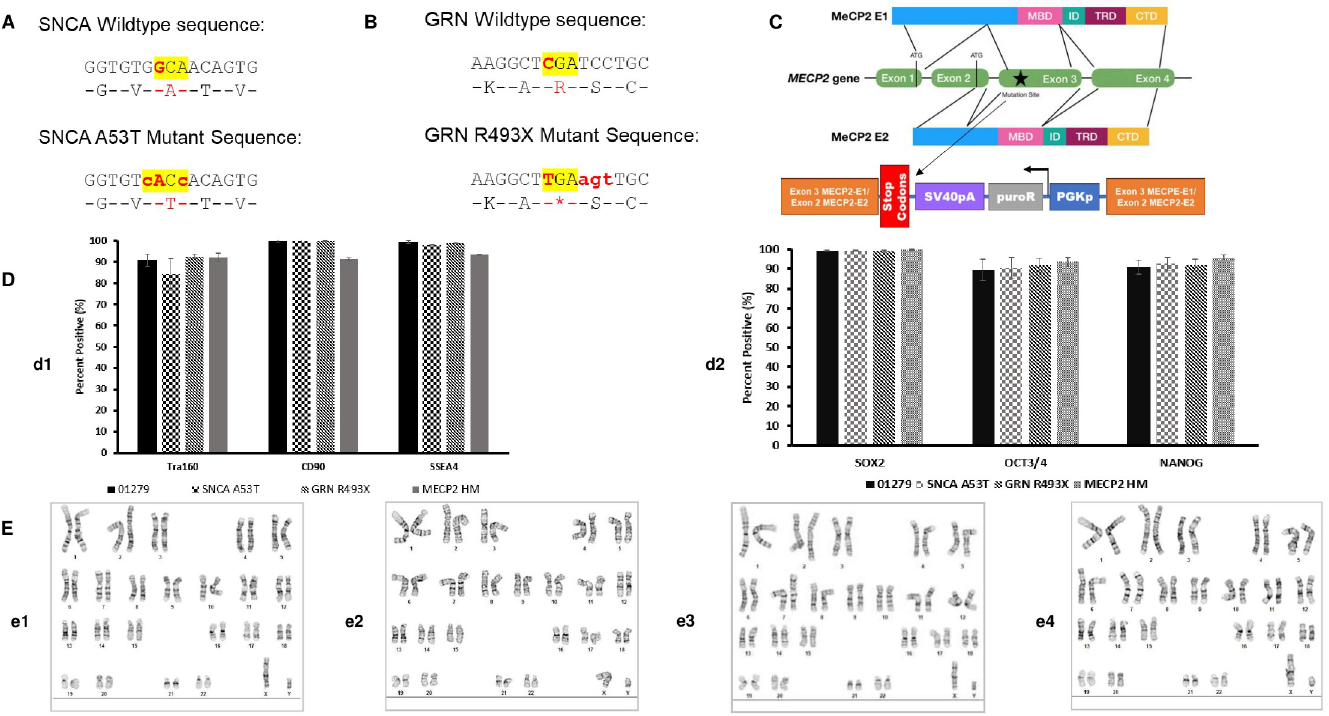
Fig 1. Generation and characterization of isogenic iPSCs for disease modelling. (A) SNCA A53T engineering is schematically described, showing the amino acid 53 change from alanine to threonine highlighted in yellow. (B) GRN R493X engineering is schematically described, showing the amino acid change of arginine 493 to a termination codon highlighted in yellow. (C) MECP2 HM KO engineering is schematically described, showing insertion of stop codons prior to Methyl CpG Binding domain followed by a PGKp-PuromycinR-SV40pA selection cassette. (D) iPSC characterization preformed using flow cytometry for the presence of traditional pluripotency markers. (d1) Detections of surface markers Tra160, CD90, SSEA4, and (d2) intracellular markers SOX2, Oct3/4, and Nanog. Each graph quantifies percentage of pluripotency markers (n = 4 ± SE) for 01279, SNCA A53T, GRN R493X, and MECP2 HM. Parental and engineered cell lines all displayed surface and intracellular markers confirming a pluripotent state. (E) Cytogenetic analysis on G-banded metaphase cells from each iPS cell line detailing a normal karyotype, (e1) 01279, (e2) SNCA A53T, (e3) GRN R493X, and (e4) MECP2 HM. G-banding karyotyping preformed and analyzed by WiCell (Madison, WI).